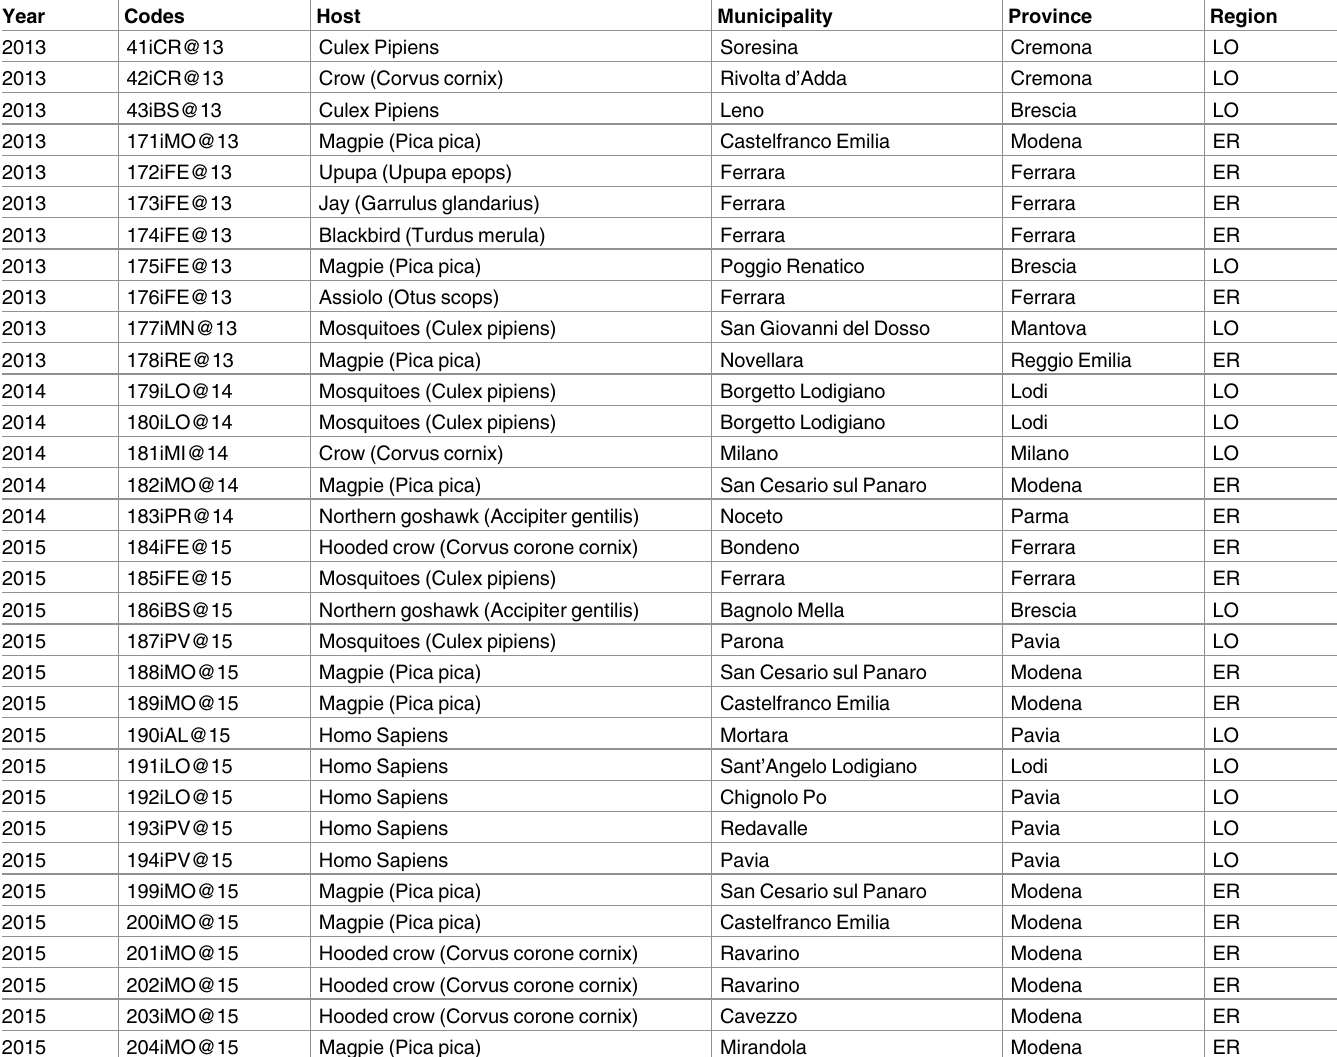
Table 1. Codes, host, localities and collection yearsof the newly characterized WNV-2 Italian sequences included in the